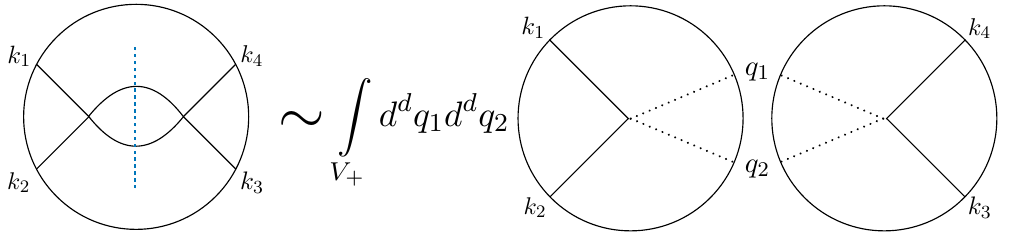
Figure 2 . A cut bubble is the on-shell gluing of contact diagrams: the undotted lines are Feynman propagators and the dotted lines are Wightman, or on-shell,